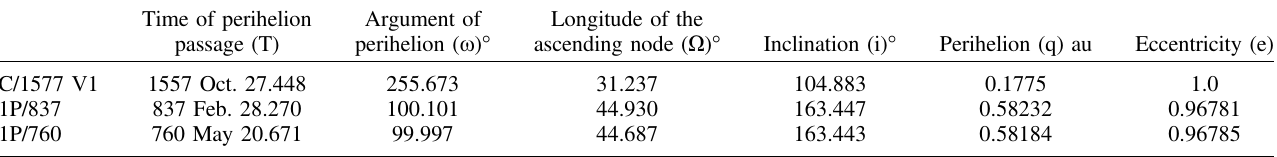
Table 1. Cometary orbital elements for the great comets examined in our article: C/1577 V1, 1P/837, and 1P/760. Time of perihelion Argument of Longitude of the passage (T) perihelion ( x ) (cid:3) ascending node ( X ) (cid:3)